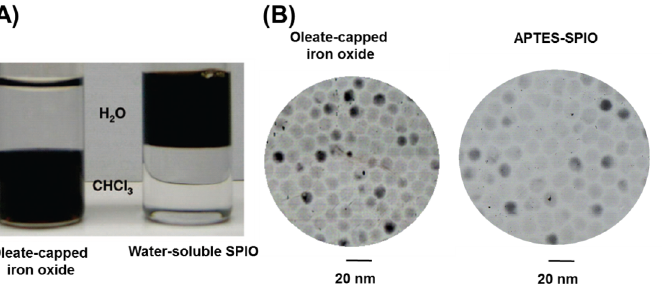
Fig 1. Manganese-doped magnetism-engineered iron oxide (MnMEIO) synthesized by thermal decomposition. (A) After modification with mPEG-NH 2 -silane, MnMEIO particles become water-soluble. (B) TEM images show that MnMEIO nanoparticles are around 12 nm in diameter with a narrow size distribution. Scale bar: 20 nm.